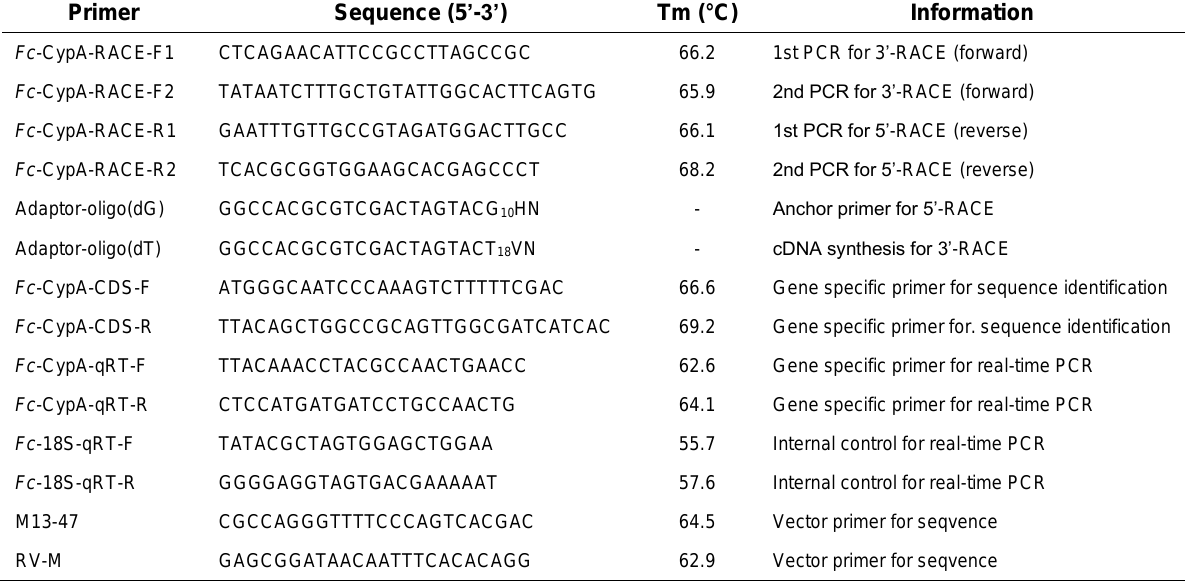
Table 1 Oligonucleotide primers used in the experiments